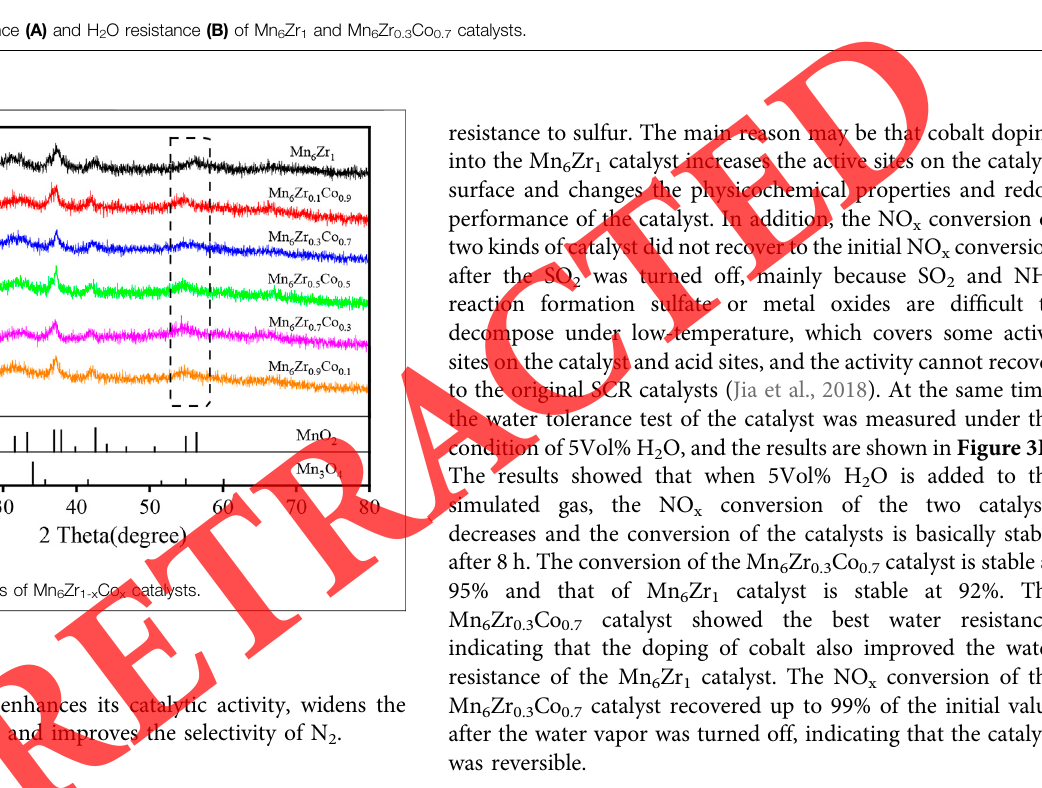
FIGURE 4 | XRD patterns of Mn 6 Zr 1-x Co x